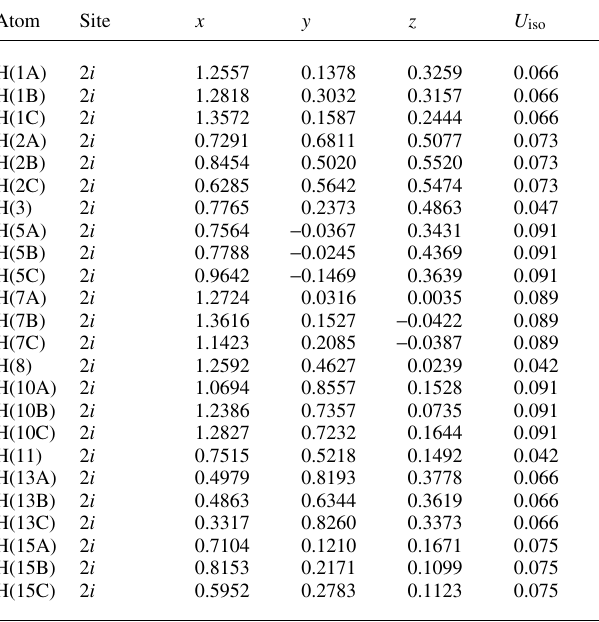
Table 2. Atomic coordinates and displacement parameters (in Å 2 )